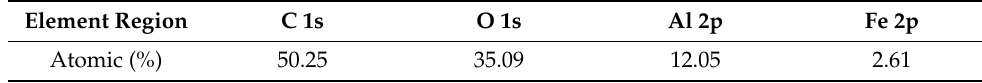
Table 4. Quantitative analysis of the sample F3